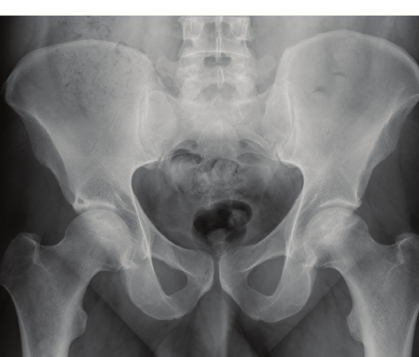
Figure 1: Anterior-posterior hip X-rays in patient number 3 at preanticoagulation study entry: both hips are Ficat stage